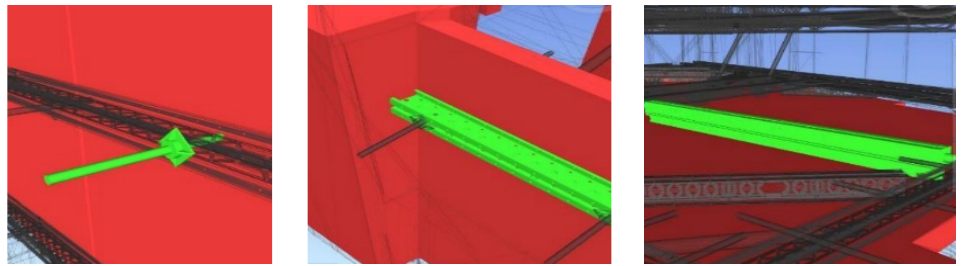
Figure 16. Results from the clash detection test.